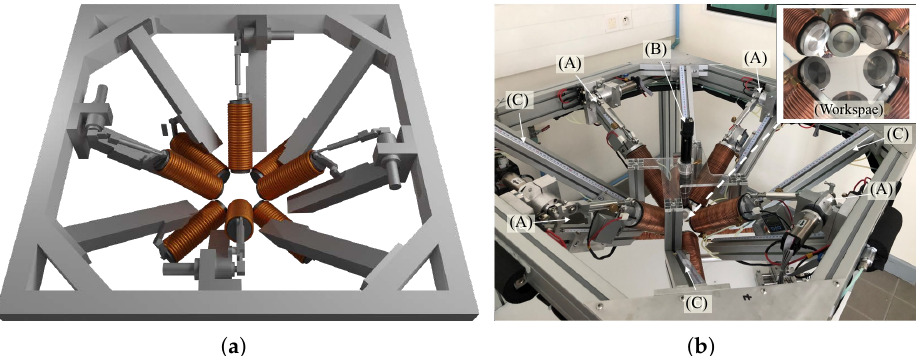
Figure 13. OctoRob design. ( a ) CAD representation of the EMA platform and ( b ) experimental prototype: (A) 1-DOD mobile robotic arms; (B) optical microscope with a CCD camera; (C) stationary robotic arms.